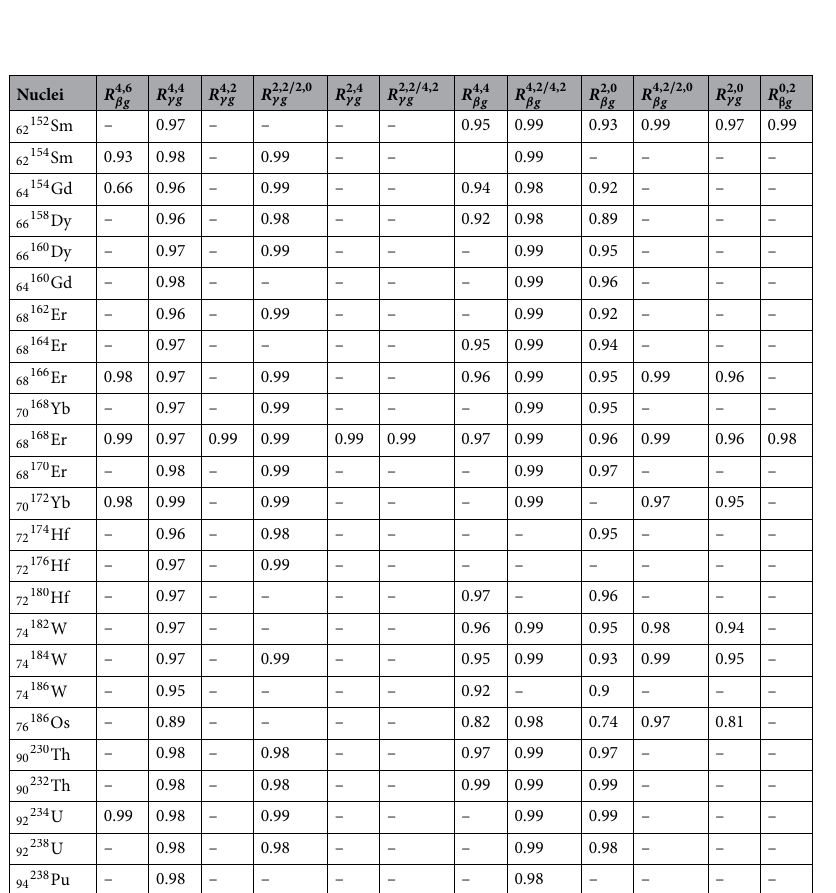
Table 2. E2 transition rate ratios for new candidates for regular